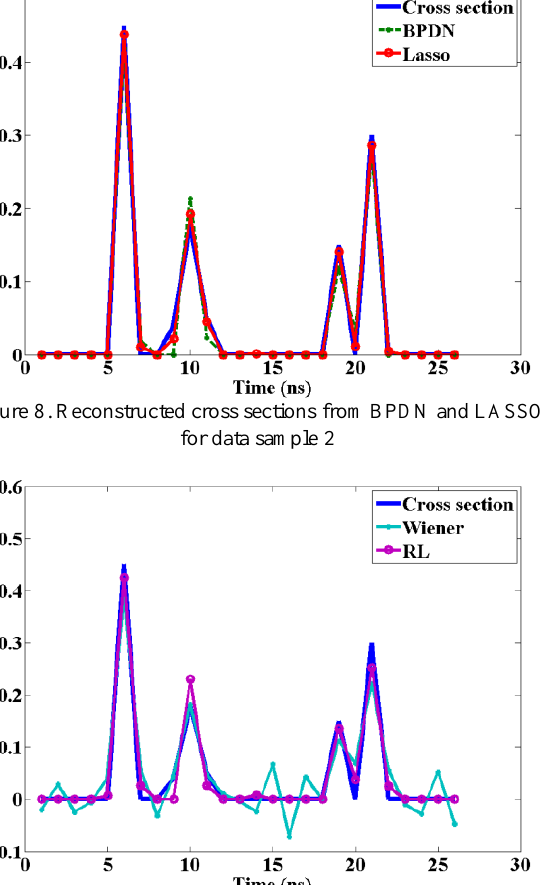
Figure 9. Reconstructed cross sections from the Wiener and RL for data sample